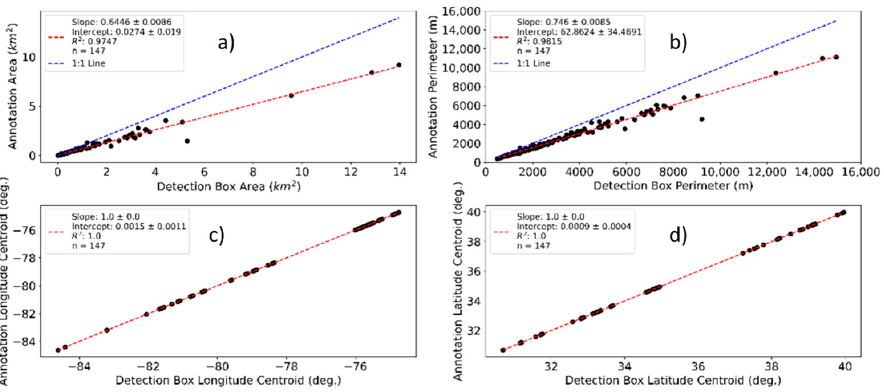
Figure 13. Comparing detection results with manually annotated polygons. Each plot shows an OLS fit with the x-axis quantity as the independent variable and the y-axis quantity as the dependent variable. One-to-one fits are plotted on the area and perimeter plots. ( a ) Area. ( b ) Perimeter. ( c ) Centroid longitude. ( d ) Centroid latitude.